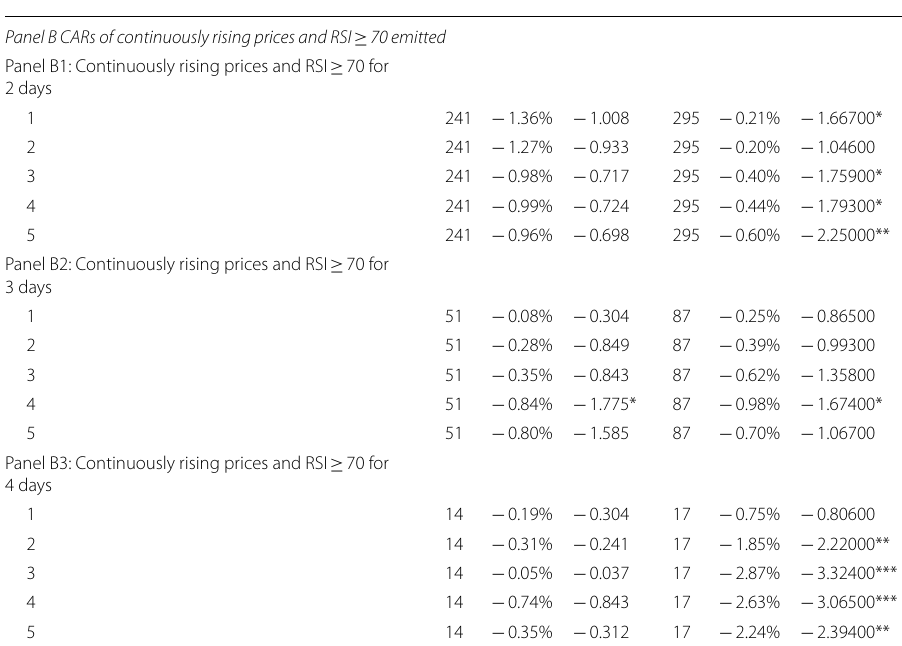
70 emitted ≥ 70 for ≥